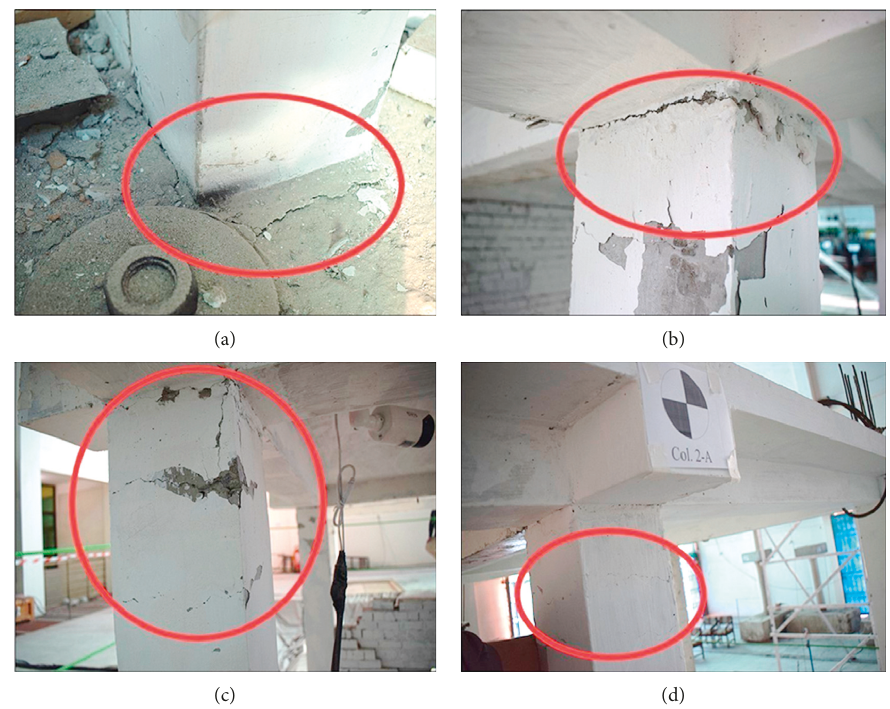
Figure 16: Damage observations of URM walls after Test Run-3. (a) Pulling out of column from foundation. (b) Flexural cracking at top end of first storey. (c) Level of cracking and spalling (1st storey). (d) Level of cracking (2nd